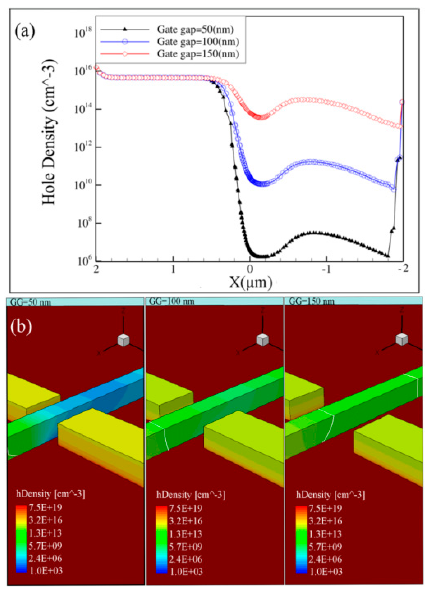
Figure 9. ( a ) Holes density distribution along the channel for the devices with three different gate gaps of 50 nm, 100 nm, and 100 nm at a cutline at Z = 50 nm, and ( b ) the corresponding side views of the holes inside the device at V D = − 1.0 V and V G = +2.0